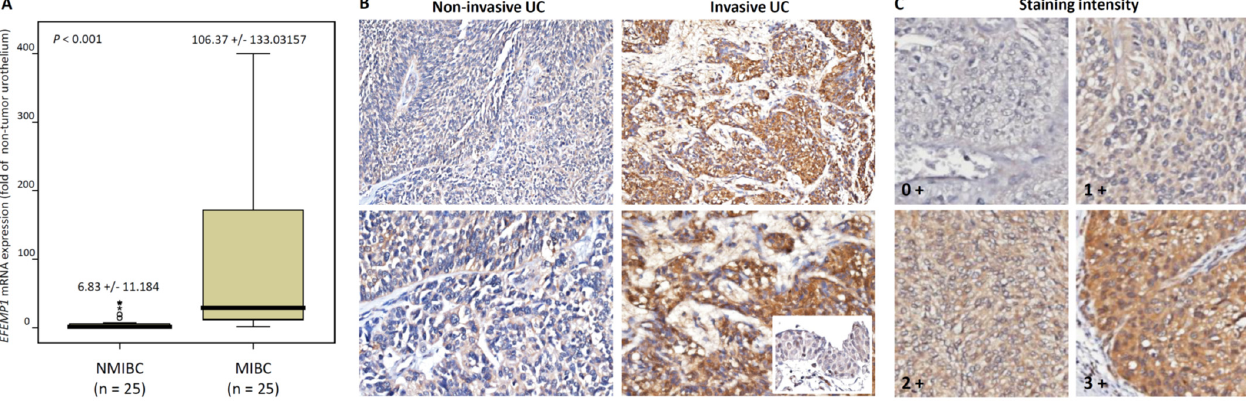
Figure 2. Expression of EFEMP1 mRNA and protein in urothelial carcinoma specimens. ( A ) EFEMP1 mRNA level was significantly increased in MIBC (pT2-T4) using qRT-PCR. ( B ) Invasive UC showed high EFEMP1 expression using immunohistochemistry (normal urothelium in the inset) (upper: magnification × 200; lower: magnification × 400). ( C ) Immunostaing intensity. * p <